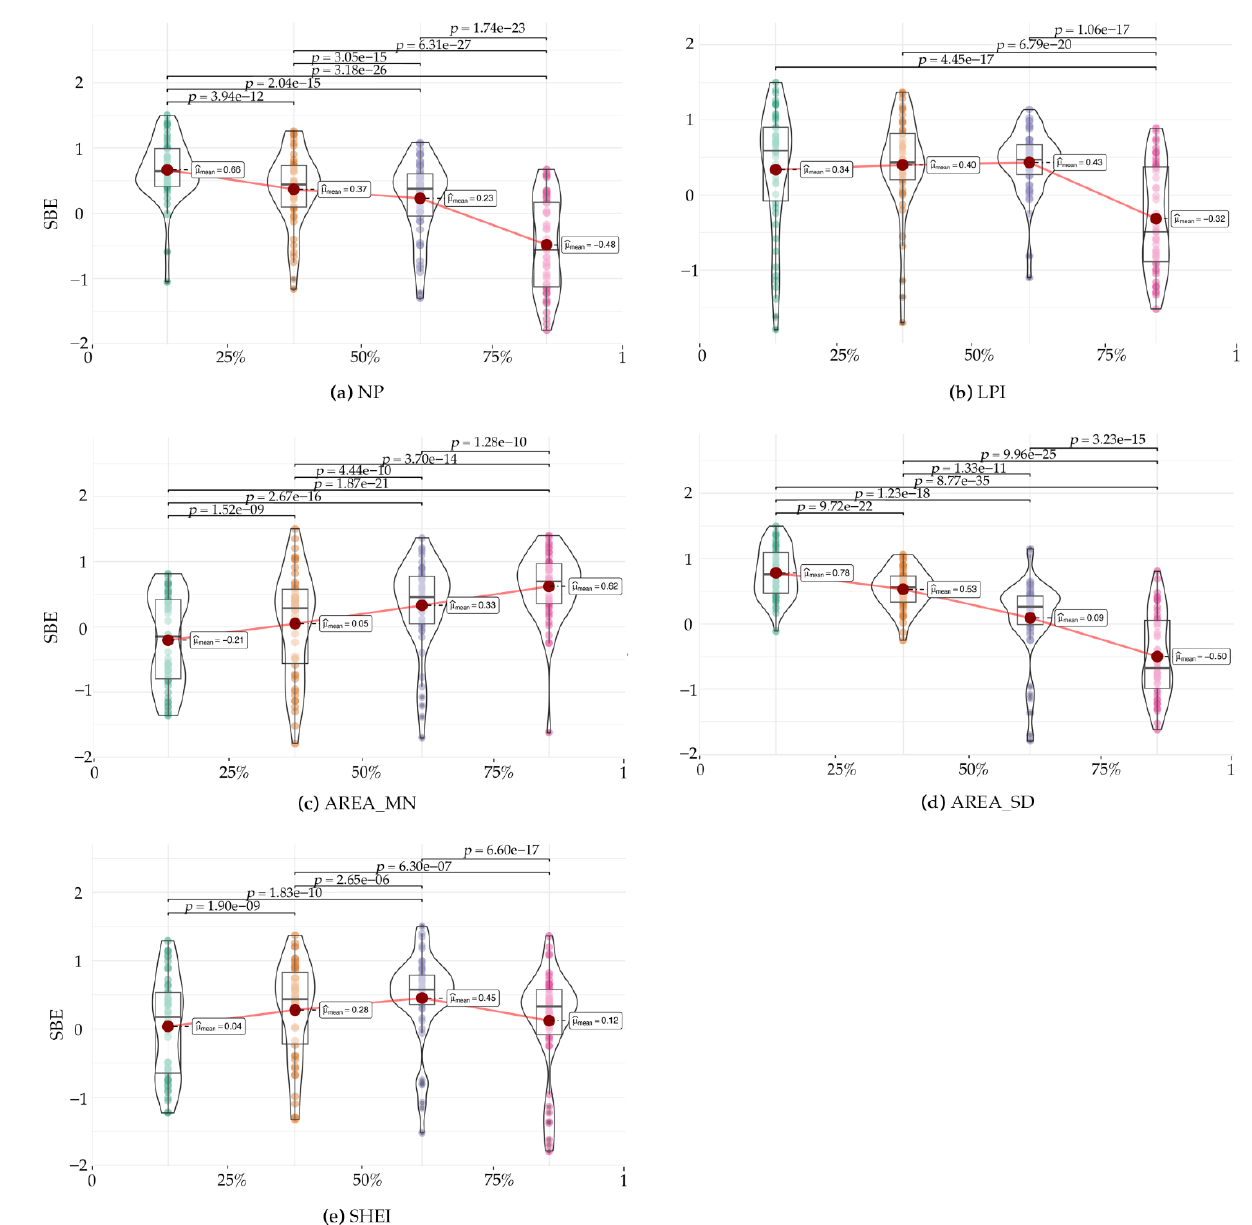
Figure 4. Correlation between color pattern metrics and visual quality of the Cotinus coggygria var. cinerea Engl. forest. The 25%, 50%, and 75% of the coordinate on the horizontal axis of each subplot represent the 1st quartile, median, and 3rd quartile of each metric. ( a ) Correlation between number of patches (NP) and SBE; ( b ) correlation between largest patch index (LPI) and SBE; ( c ) correlation between mean patch area (AREA_MN) and SBE; ( d ) correlation between patch size standard deviation (AREA_SD) and SBE; ( e ) correlation between Shannon’s evenness index (SHEI) and SBE .